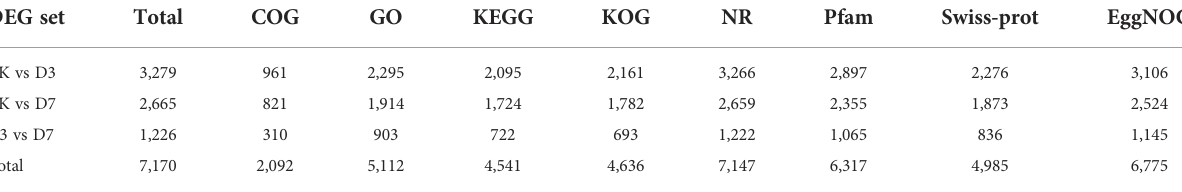
TABLE 2 The number of annotated differentially expressed genes